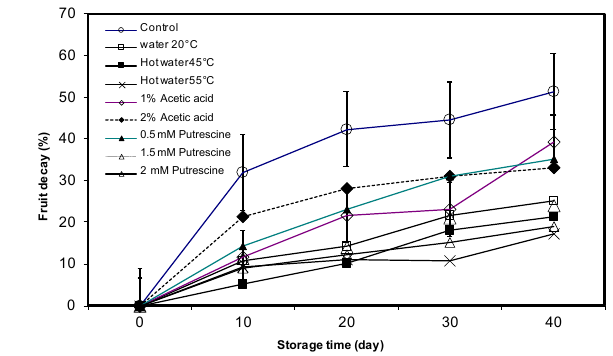
Figure 2. Mean incidence (± standard deviation; n = 3) of decay due to brown rot for cv. Shahrodi apricots before and during stor- age for 40 d at 5°C following different